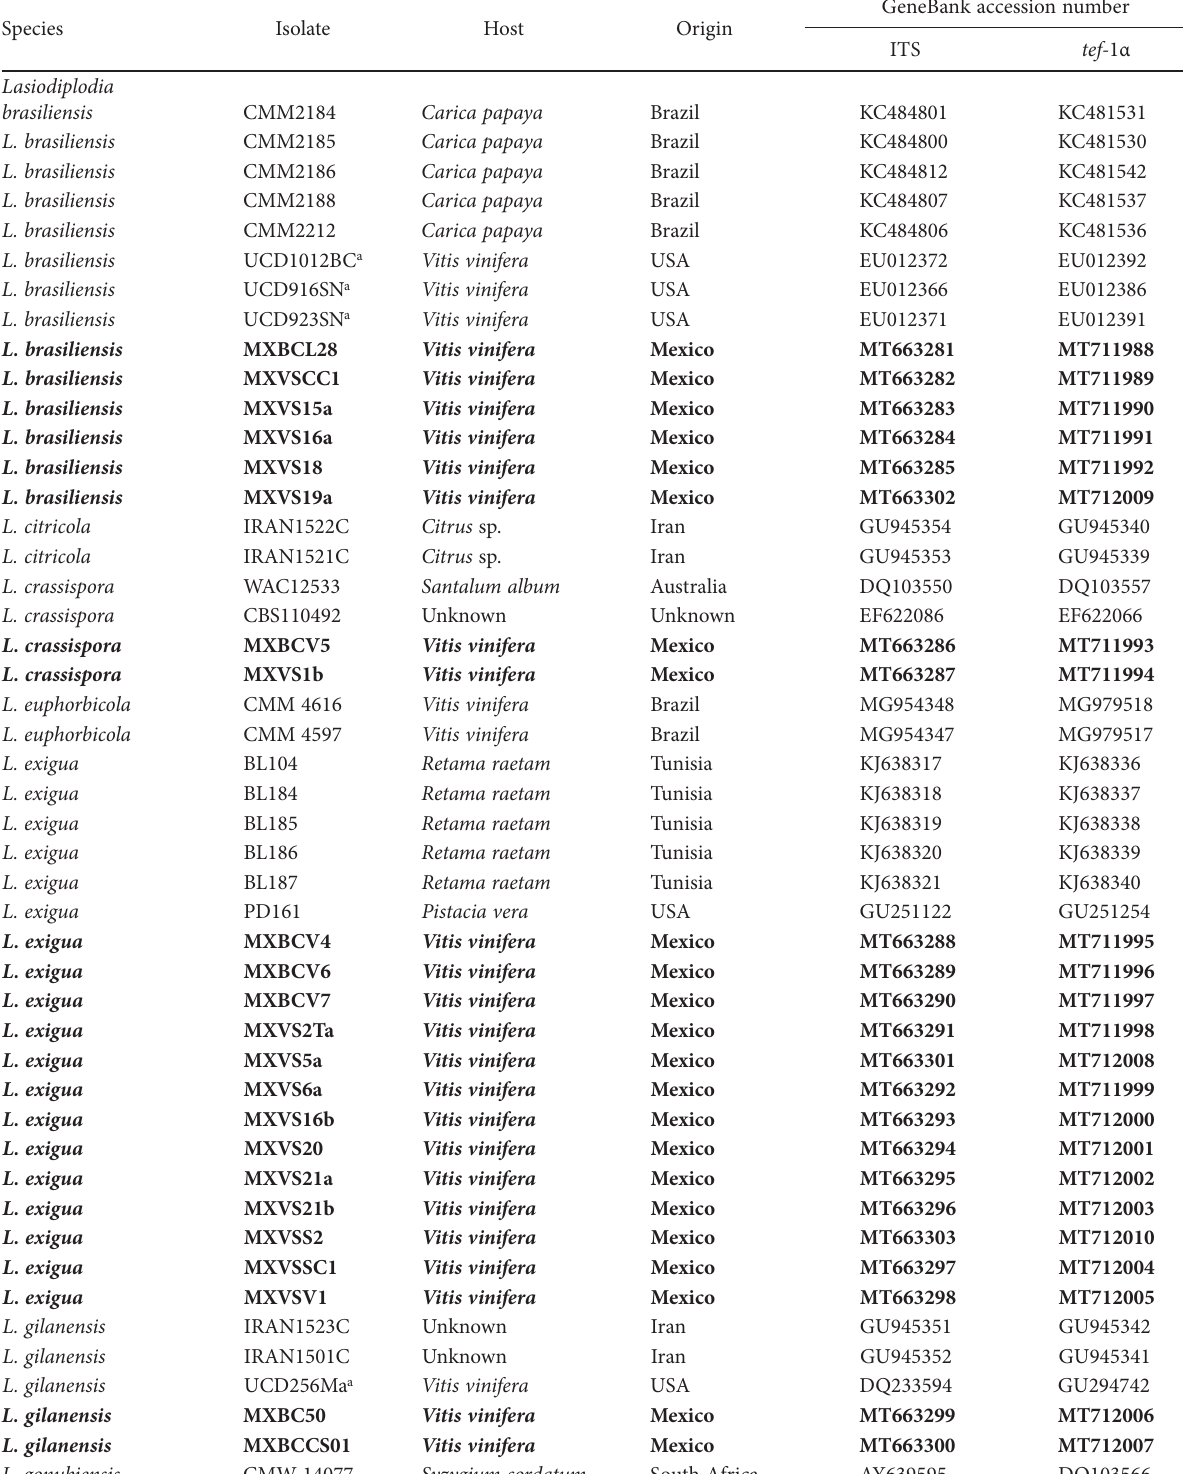
Table 1. List of GenBank and culture accession numbers of Lasiodiplodia spp. used in this study for phylogenetic analyses.